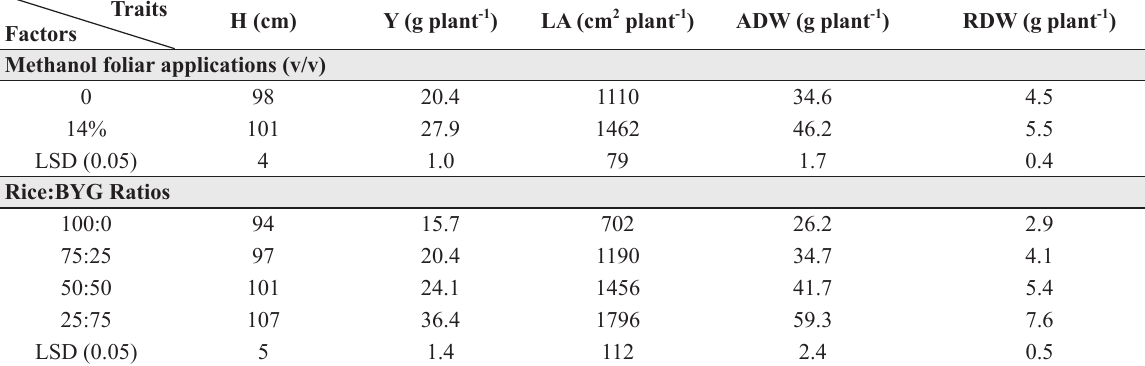
Rice plant height (H), grain yield (Y), leaf area (LA), aboveground weight (ADW) and root dry weight (RDW) response to methanol foliar application (M) and rice:barnyardgrass (BYG) mixture proportion, averaged across two years. Traits Factors